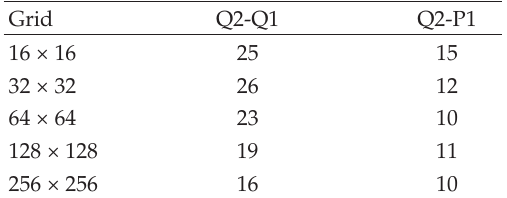
Table 1: Iterations of preconditioned GMRES (cid:4) 30 (cid:5) for steady Stokes